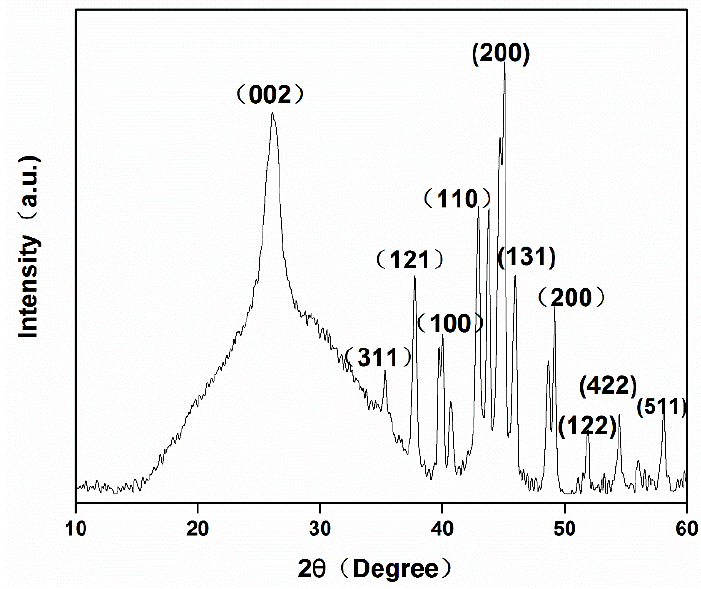
Figure 5. XRD pattern of Fe/CA.